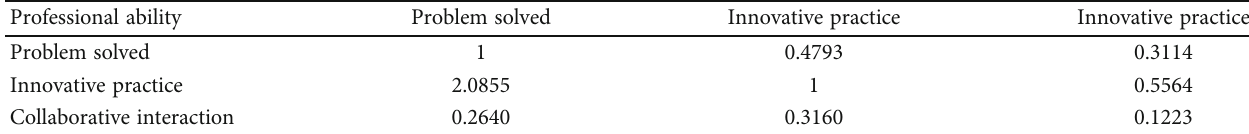
Table 3: Judgment matrix of secondary indicators under professional competence after